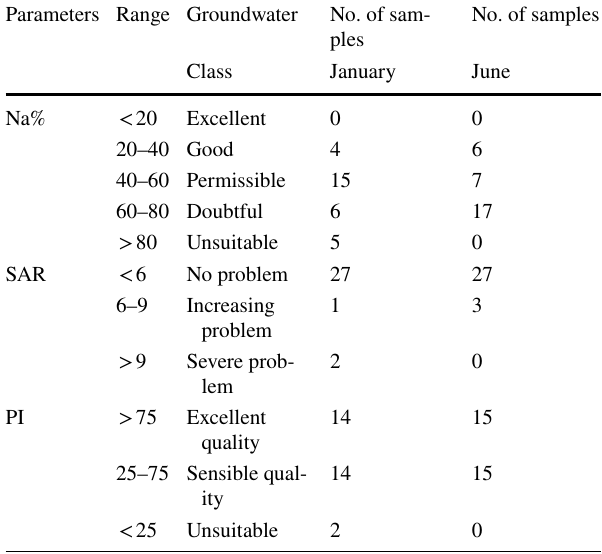
Table 5 Classification of groundwater for irrigation purposes based on the three indices of Na% (Wilcox LV 1955), SAR (Bouwer H 1978) and PI Parameters Range